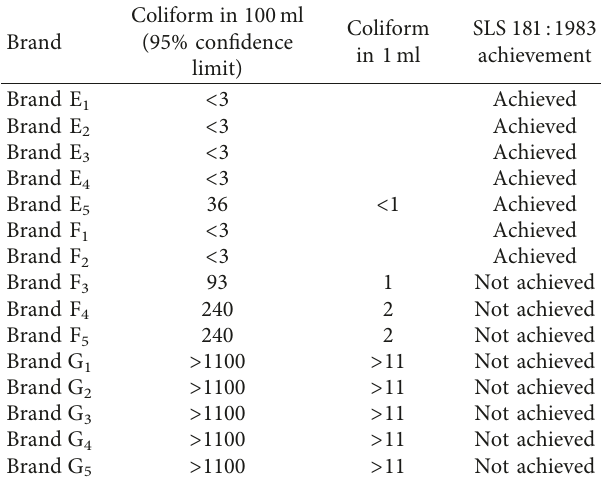
Table 5: Total coliform count in PM